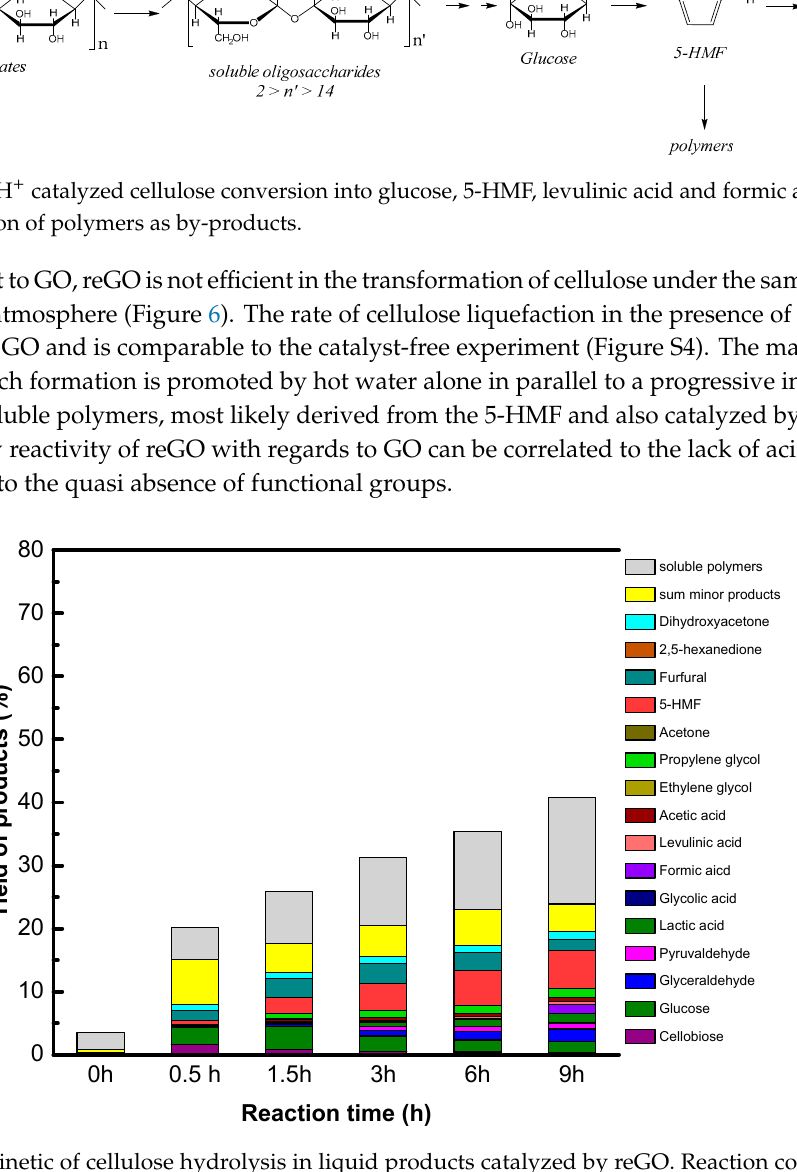
Figure 6. Kinetic of cellulose hydrolysis in liquid products catalyzed by reGO. Reaction conditions: T = 190 °C, p~11at, m catalyst = 0.68g, m cellulose = 1.6g, m water = 65g, and Ar Atm.